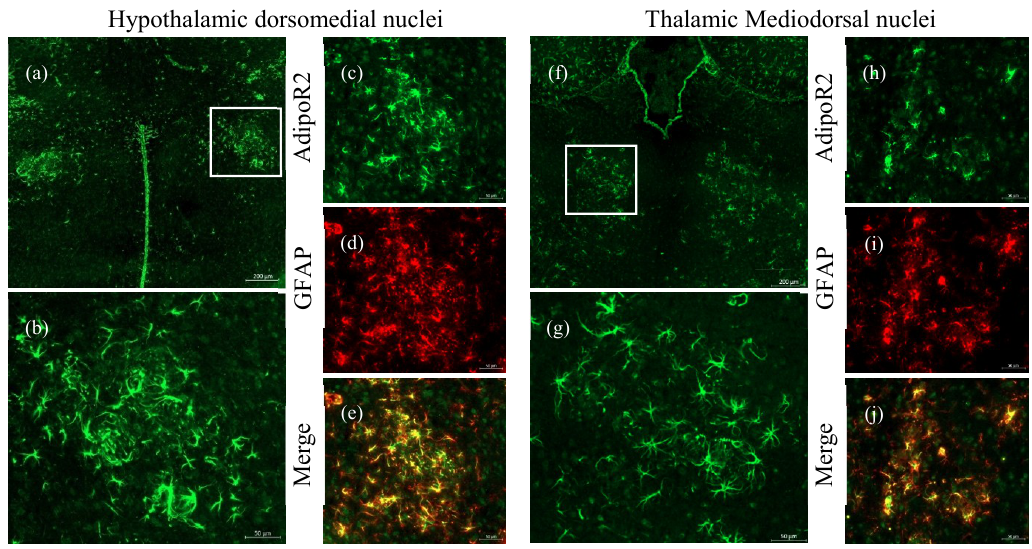
Figure 5. Astrocytes localised to the hypothalamic dorsomedial (DMHa) and thalamic mediodorsal (MD) regions in an aged 5XFAD mouse brain. Increased presence of AdipoR2 in the DMHa ( a – c ) and MD ( f – h ) in the thalamic nuclei of aged 5XFAD mice. Astrocytic expression of AdipoR2 ( e , j ) was confirmed by double-labelling with GFAP ( d , i ). Images were acquired at 20 × magnification. Scale bars for ( a ) and ( f ) are 200 μ m, ( b )–( e ) and ( g )–( j ) are 50 μ m.